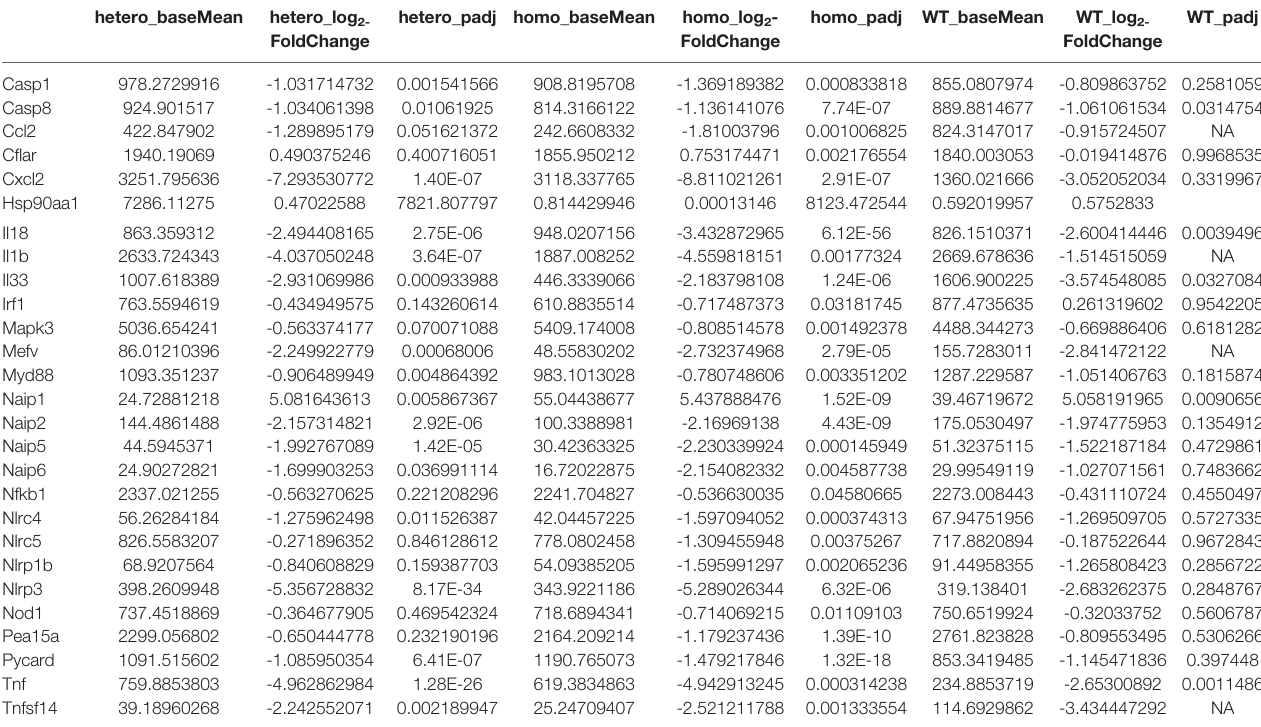
TABLE 1 | Changes of the mRNA expressions of the autoin fl ammatory lesional skins in KI mice and WT mice after UVB irradiation, compared to before UVB irradiation.